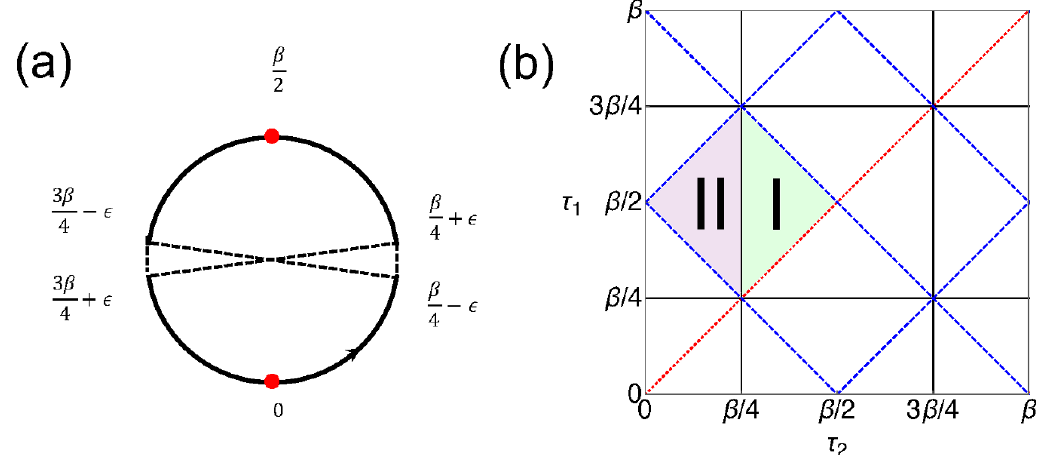
Figure 4 . (a) The twisted boundary condition on the imaginary time circle. When (cid:28) crosses (cid:12)= 4 from below, ( (cid:28) ) becomes a superposition of ( (cid:12)= 4 + (cid:15) ) and (3 (cid:12)= 4 (cid:0) (cid:15) ) (see eq. (3.16). (b) The various symmetry and boundary conditions on the twisted two point function in the ( (cid:28) 1 ; (cid:28) 2 ) plane. First, G (cid:22) is odd under re(cid:13)ections across the red dotted line and even under re(cid:13)ections across the blue dashed lines. Thus, it is su(cid:14)cient to solve the saddle-point equations in the fundamental domain 0 < (cid:28) 1 (cid:0) (cid:28) 2 < (cid:12)= 2 and (cid:12)= 2 < (cid:28) 1 + (cid:28) 2 < (cid:12) . The black lines are the locations of the twisting boundary conditions (3.17), which reduce in the large q limit (4.7) and divide our fundamental domain into two regions. Region I is where neither of the two fermions have crossed a twist, while in Region II the fermions are on opposite sides of the